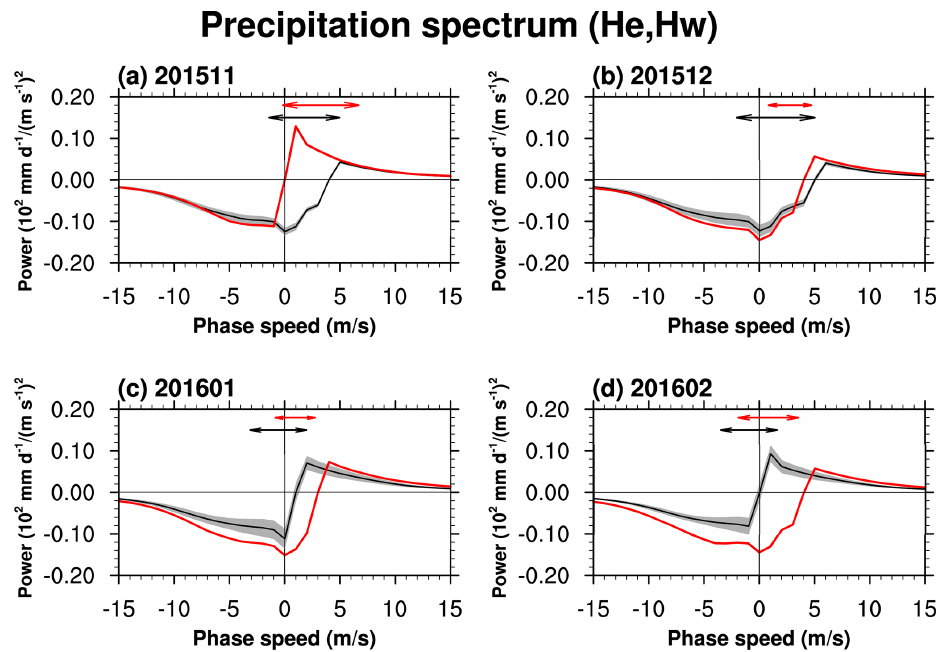
Figure 13. Phase-speed spectra of the precipitation in the spectral range of the H e + H w waves ((i) | k | > 20 and ω > 0cpd or (ii) | k | ≤ 20 and ω > 0 . 4cpd; approximately for the IG waves) averaged over 10 ◦ N–10 ◦ S in (a) November 2015, (b) December 2015, (c) January 2016, and (d) February 2016, along with their monthly climatology (black) with ± 1SD (gray shading). Note that the power is multiplied by a negative sign when the phase speed is smaller than the zonal-mean zonal wind at 140hPa (i.e., source level). Double-sided arrows represent zonal wind ranges from 140 to 70hPa for the QBO disruption period (red) and the climatology